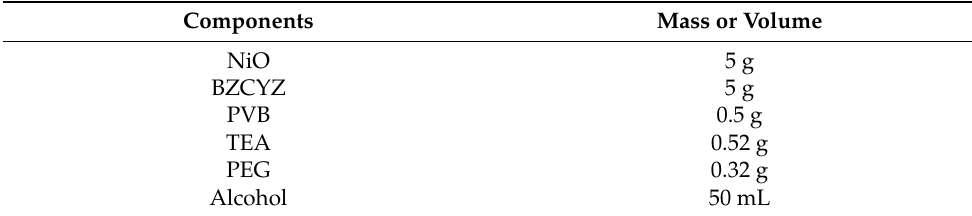
Table 2. Composition of anode functional layer slurry.